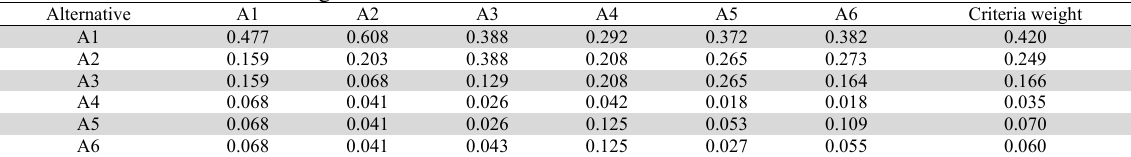
Normalised matrix and criteria weight Alternative